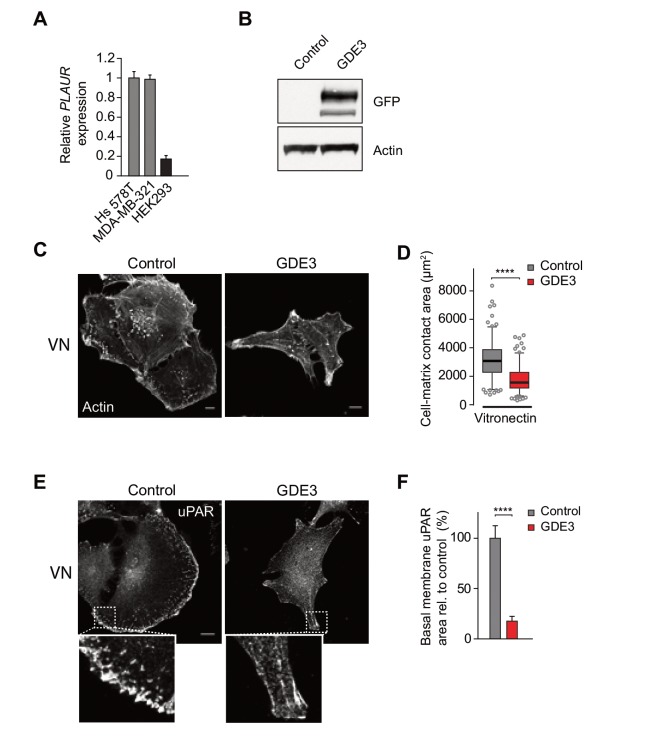
GDE3 overexpression suppresses the uPAR-vitronectin-dependent phenotype in Hs578T breast cancer cells.(A) Relative expression of uPAR (encoded by PLAUR)) in the indicated cell lines, as determined by qPCR. (B) GDE3-GFP expression in Hs578T cells, using anti-GFP antibody. (C) Confocal images showing cell morphology (F-actin staining) of GDE3-expressing versus control cells plated on vitronectin (Bar, 10 μm). (D) Quantification of cell area of GDE3-expressing versus control Hs578Tcells, plated on vitronectin (n = 3, mean ±SEM, ****p<0.0001). (E) Hs578T cells with or without stable GDE3-GFP expression were plated on vitronectin and stained for endogenous uPAR. Representative images of the basolateral membrane are depicted. Bar, 10 μm. (F) uPAR in the basolateral membrane was quantified in control and GDE3-expressing Hs578T cells plated on vitronectin (n = 3, mean ±SEM, ****p<0.0001).